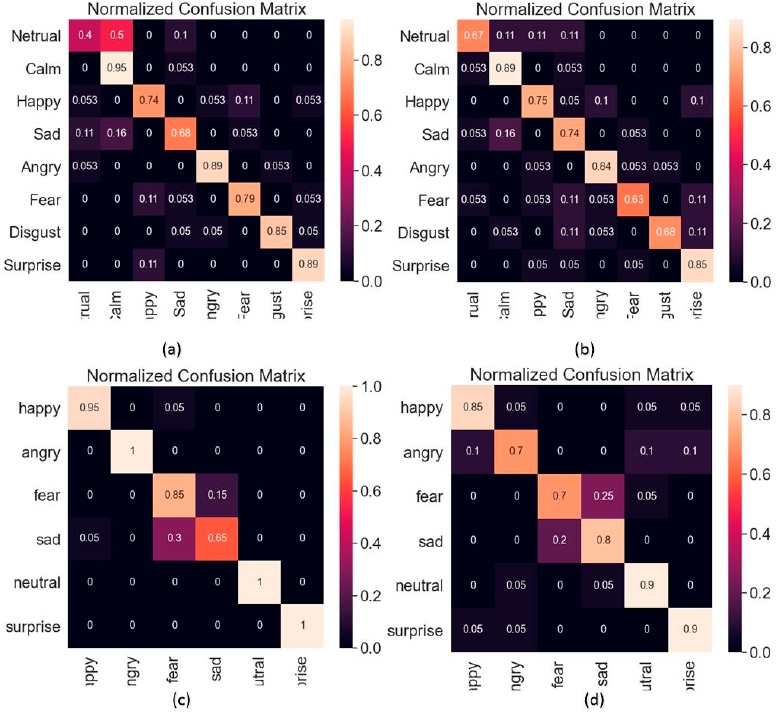
Figure 6. BiLSTM recognition results. ( a ) Result of male speech in RAVDESS dataset. ( b ) Result of female speech in RAVDESS dataset. ( c ) Result of male speech in CASIA dataset. ( d ) Result of female speech in CASIA dataset.